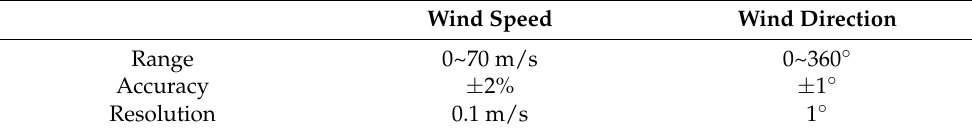
Table 1. Specifications of the